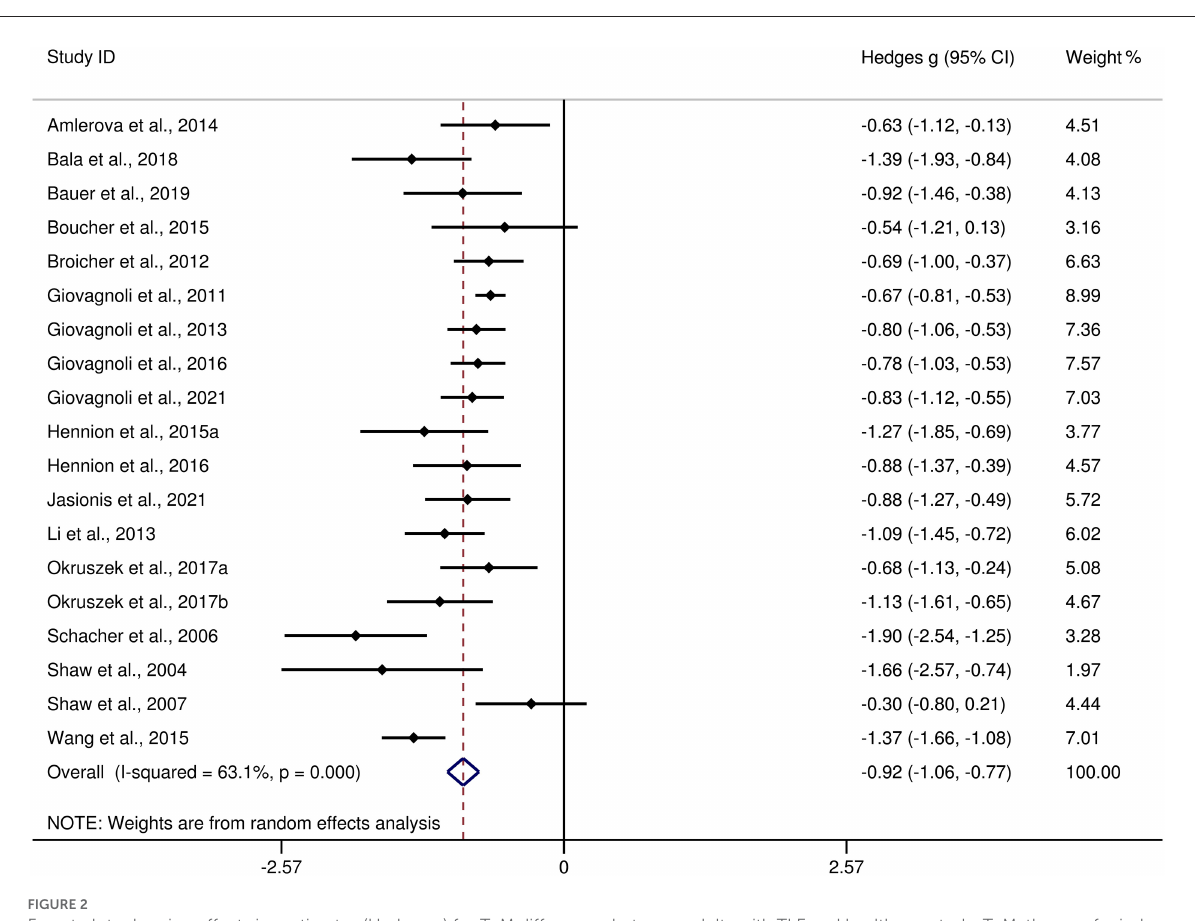
Table 3 show the key results from this meta-analysis. Compared to HCs, adult patients with TLE were impaired in ToM and this deficit was large in magnitude ( g = − 0.92, 95%